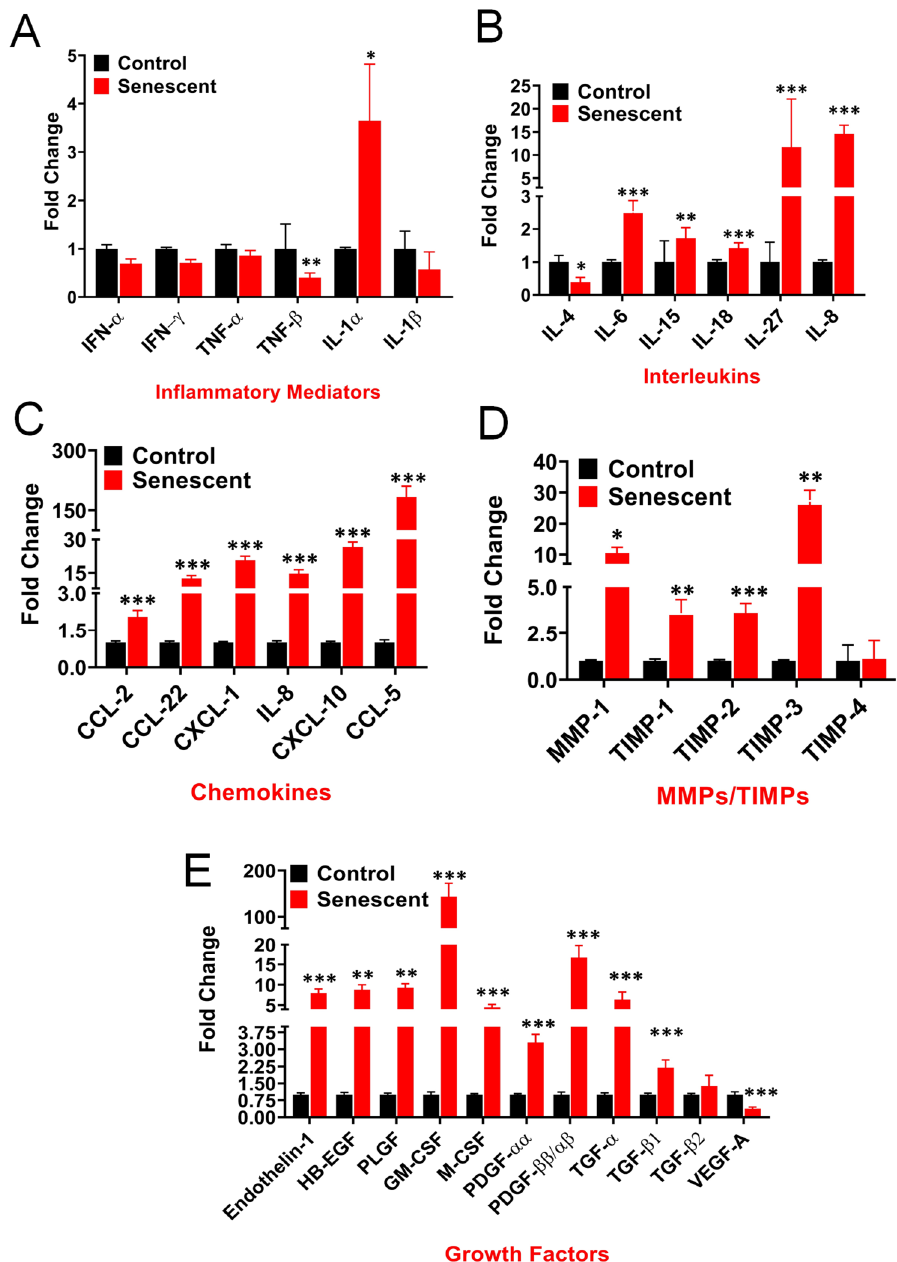
Figure 2. Proteins secreted by control and senescent HCT-116 cells (SCC). Data shown in the figures are expressed as fold changes in senescent cells relative to control and are means ± SD of four individual samples. ( A ) The secretion of inflammatory mediators by control and SSC. ( B ) The secretion of interleukins by control and SCC. No detectable secretion of the following cytokines was observed in both control and SCC: IL-2, IL-3, IL-5, IL-7, IL-9, IL-10, IL-12, IL-13, IL-17 and IL-22. ( C ) The secretion of chemokines by control and SCC. No detectable secretion of the following chemokines was observed in both control and SCC: MIP-1 α (CCL-3), MIP-1 β (CCL-4), MCP-3 (CCL-7), Eotaxin (CCL-11), MIG (CXCL-9) and Fractalkine (CX3CL-1). ( D ) The secretion of matrix metalloproteases and TIMPs by control and SCC HCT-116. No detectable secretion of the following MMPs was observed in both control and SCC: MMP-2, 3, 7, 8, 9, 10, 12 and 13 ( E ) The secretion of growth factors by control and SCC. No detectable secretion of the following growth factors was observed in both control and SCC: angiopoetin-2, BMP-9, EGF, endoglin, FGF-1, FGF-2, Follistatin, G-CSF, HGF, Leptin, VEGF-C, VEGF-D and TGF- β 3. * p value < 0.05; ** p value < 0.01, *** p value <